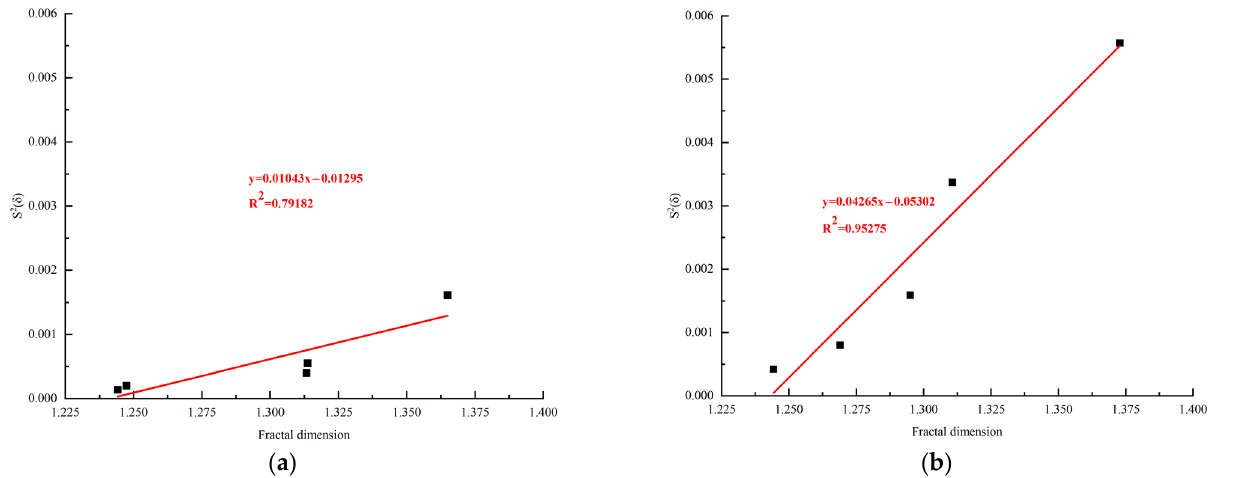
Figure 11. Relationship between fractal dimension and variance of the cumulative pile top displace- ment increment data group. ( a ) Peak value of cyclic load: 3 N. ( b ) Peak value of cyclic load: 4 N.